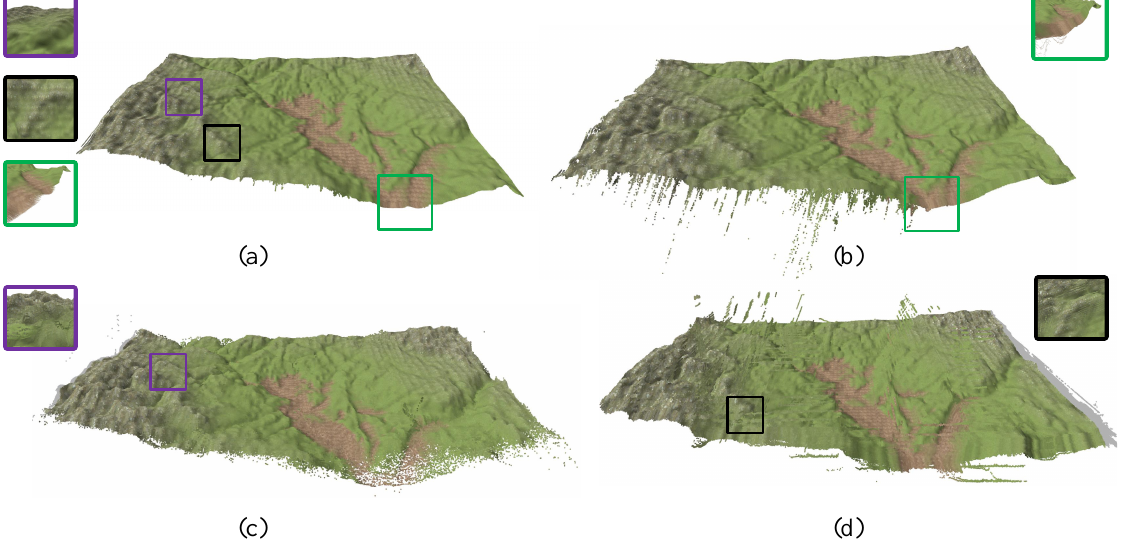
Figure 12. Global mapping of four methods: ( a ) proposed method ( b ) quadtree-mapping ( c ) REMODE, and ( d ) probabilistic mapping. The selected areal shows the detail of point